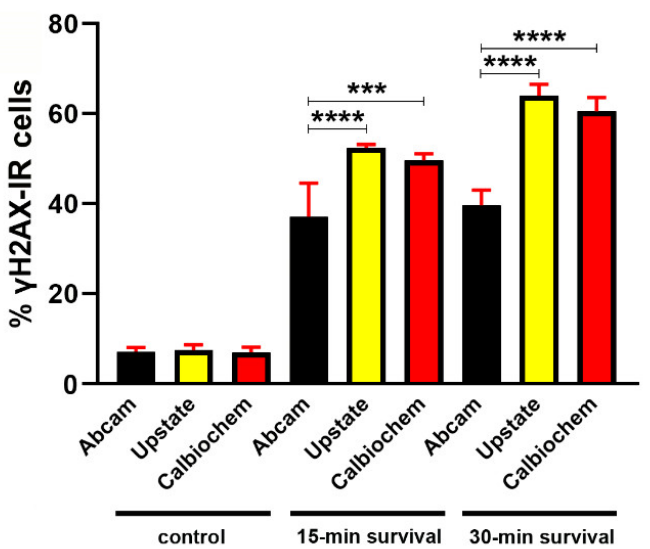
Figure A1. Percentages of γ H2AX immunoreactive nuclei versus the total number of nuclei after labeling with DAPI in the cerebral cortex of control and irradiated mice after immunostaining with different anti- γ H2AX primary antibodies. For each experimental mouse, two slides containing three serial sections of the forebrain were randomly picked up from series of the whole brain. Each section was single labeled with one of the three anti- γ H2AX primary antibodies, counterstained with DAPI, and five random microscopic fields of the cerebral cortex were photographed at 40 × under the Leica DM 6000 wide-field fluorescence microscope. Positive cells were counted as indicated in Material and Methods. Note that in control animals there are not statistically significant differences in the percentages of immunoreactive nuclei (Abcam 7.104 ± 0.693, Upstate 7.448 ± 0.927, Calbiochem 6.968 ± 0.738; ordinary one-way ANOVA F value 0.5127, p value 0.6154). On the other hand, in 15 min and 30 min survivors staining with the Abcam antibody yielded statistically significant lower per- centages of immunoreactive cells compared to the two other antibodies. Results in 15 min survivors were Abcam 37.09 ± 5.74, Upstate 52.41 ± 0.54, Calbiochem 49.64 ± 1.01; ordinary one-way ANOVA F value 34.76, p value < 0.0001; multiple comparisons: Abcam vs. Upstate adjusted p value < 0.0001, Abcam vs. Calbiochem adjusted p value = 0.0003, Upstate vs. Calbiochem adjusted p value = 0.3755. Results in 30 min survivors were Abcam 39.64 ± 2.95, Upstate 64.01 ± 2.22, Calbiochem 60.56 ± 2.06; ordinary one-way ANOVA F value 194.5, p value < 0.0001; multiple comparisons: Abcam vs. Up- state adjusted p value <0.0001, Abcam vs. Calbiochem adjusted p value < 0.0001, Upstate vs. Cal- biochem adjusted p value = 0.0701. Data are expressed as mean ± 95% CI. *** 0.001 > p ≥ 0.0001, **** p < 0.0001. Bars are 95%